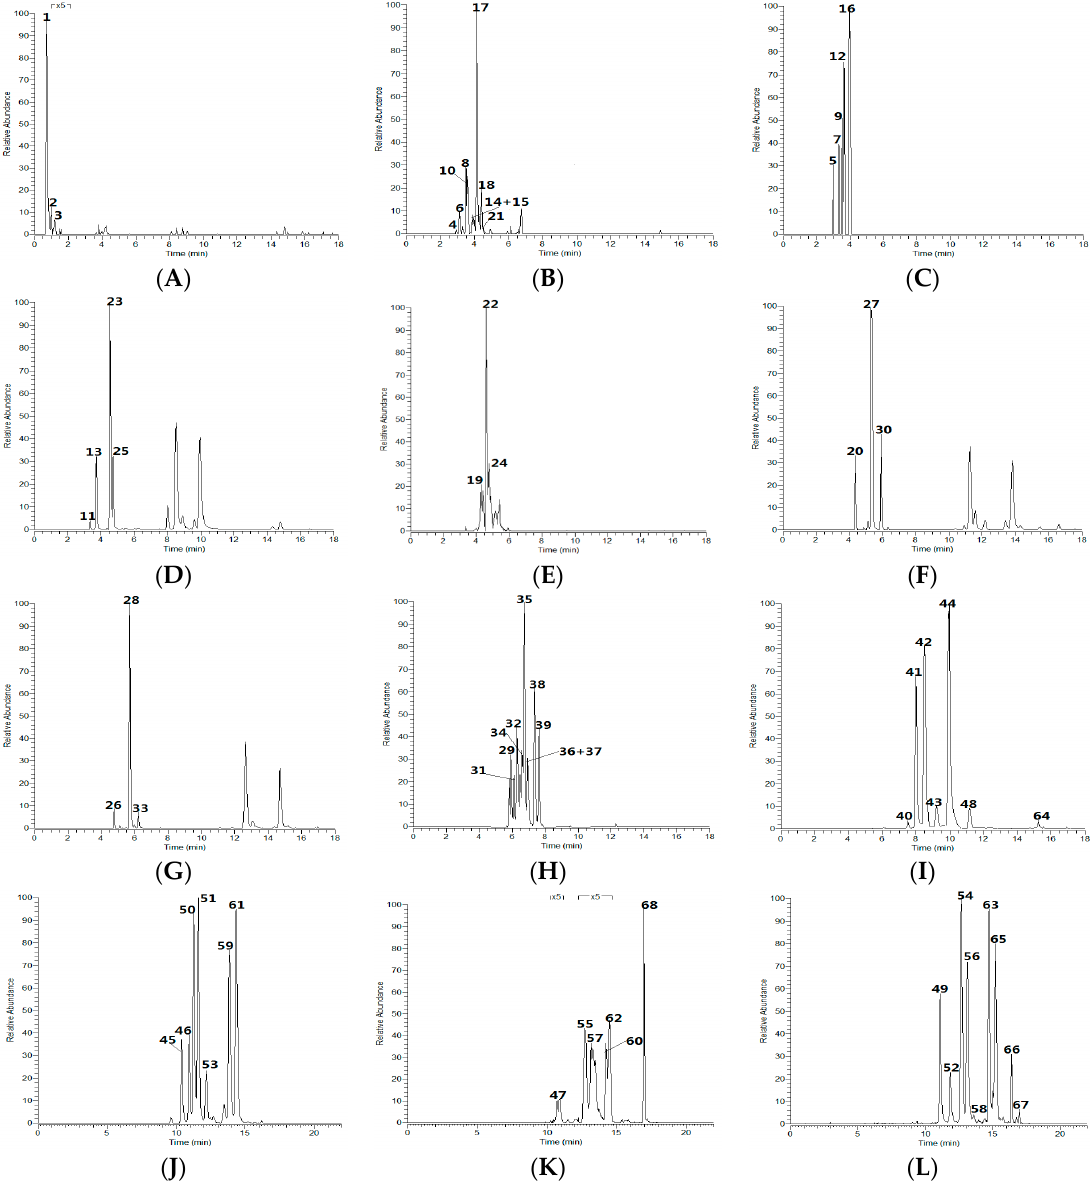
Figure 2. The distributions of 68 CGAs attributed to 12 categories in Kuding tea ( S1 ). ( A ) QA-Glc; ( B ) CQA-Glc; ( C ) CQA-DiGlc; ( D ) CQA; ( E ) CFQA-Glc; ( F ) p -CoQA; ( G ) FQA; ( H ) DiCQA-Glc; ( I ) DiCQA; ( J ) p -CoCQA; ( K ) TriCQA; ( L )